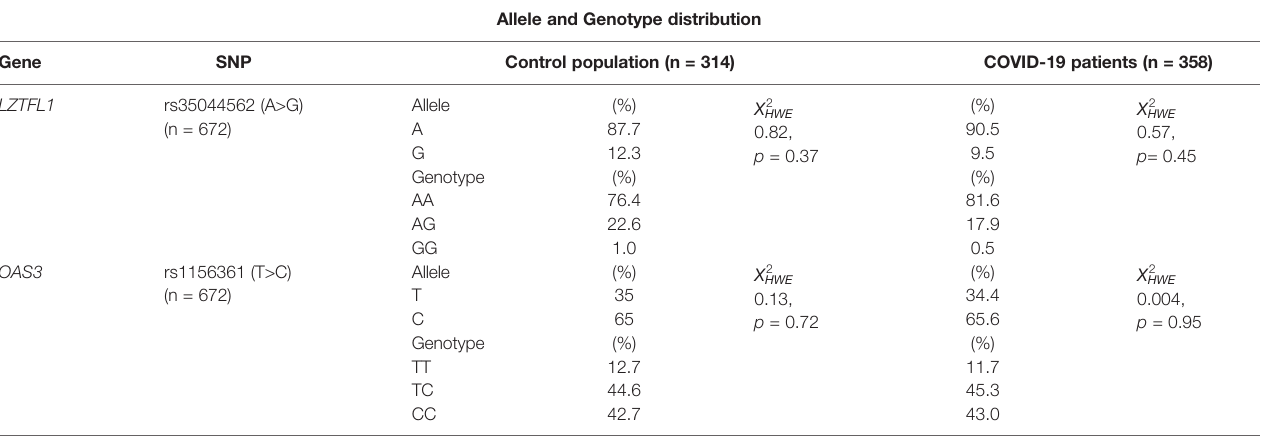
TABLE 1 | Allele and Genotype distribution of rs35044562 and rs1156361 in the control population and COVID-19 patients. Allele and Genotype